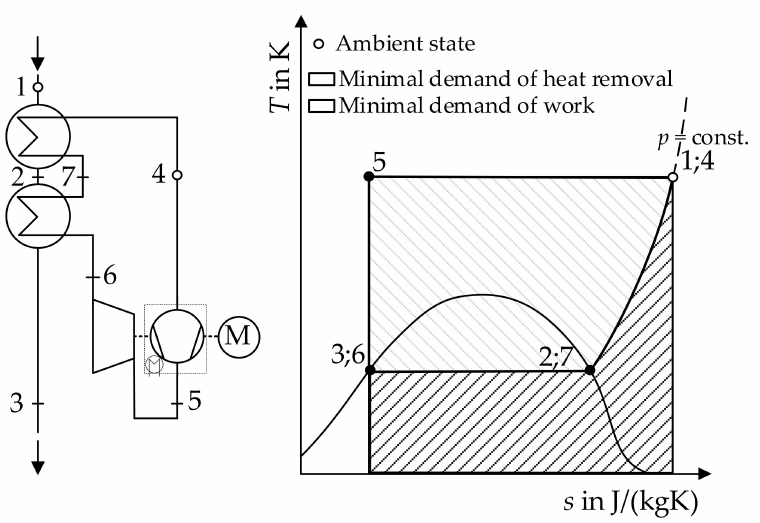
Figure 4. Flow chart and T-s -diagram of the ideal gas liquefaction, emulated from [16] (p. 326). The mass flow of the gas in the chiller cycle equals the outer mass flow of the gas intended to be liquefied [16] (p. 324). The compression (state 4 to state 5) is isothermal in the ideal case. The compressed gas subsequently passes the isentropic expansion machine, reaching the boiling point curve (state 6) on the same isobar as state 1. In two ideal